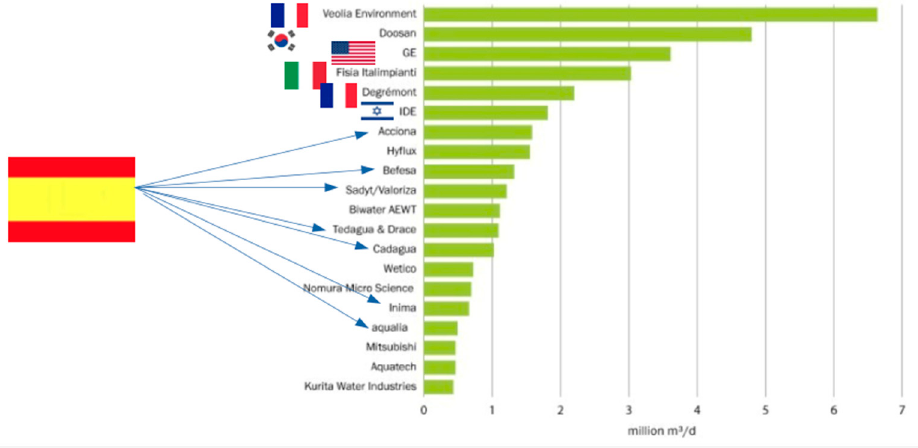
Figure 2. Companies with the largest installed capacity. Source: Own elaboration from International Desalination Association (IDA), (2019).